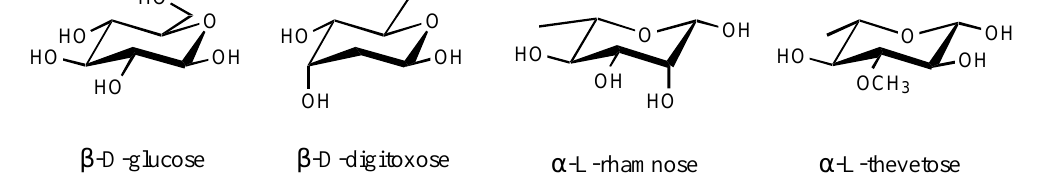
Figure 14. Structure of some of the sugars present in digitalis